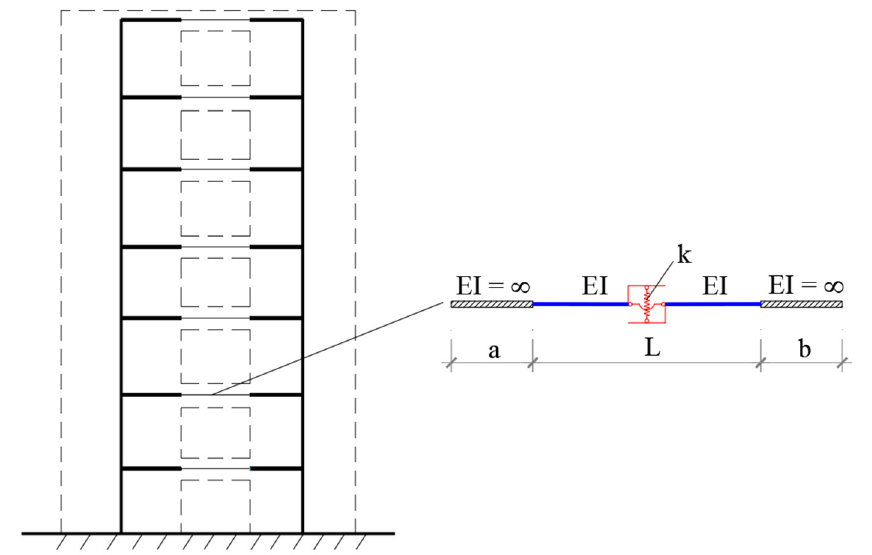
Figure 5. Structure of the beam with rigid ends.